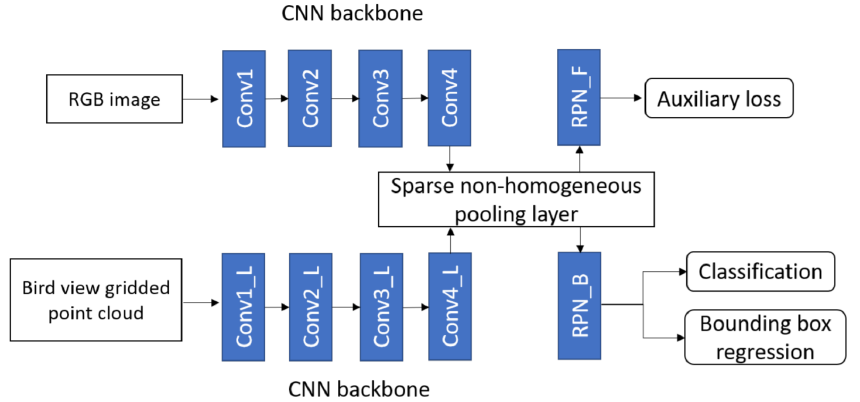
Figure 21. The fusion-based one-stage object detection [74] network.